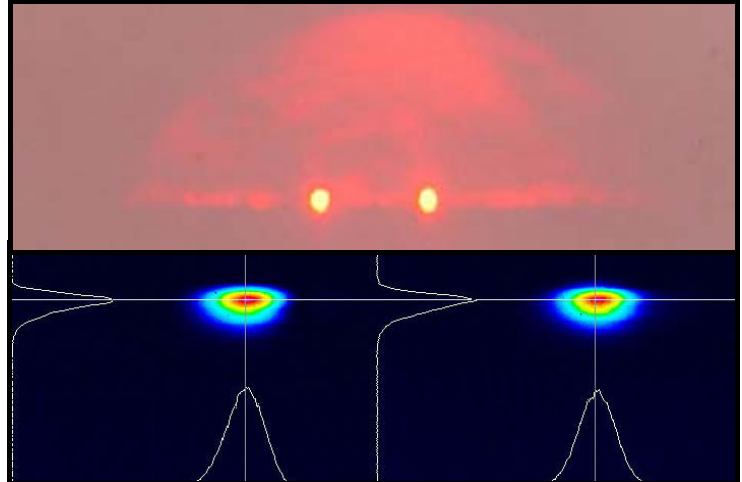
The Y-junction was characterized with the same laser source used for the prototype device and with an electronic circuit for the real time measurement of the output ratio between the reference and SPR branches (a picture of the output face, with the two laser spots images and intensity maps, is given in Figure 11), finding a 85 dB rejection of “common mode” measurements fluctuations. Figure 11. Output face of the Y-junction device: upper, picture of the spot images; lower, picture of the intensity maps obtained with a beam profiler (the curves correspond to the intensity along the superimposed horizontal and vertical lines passing from spot